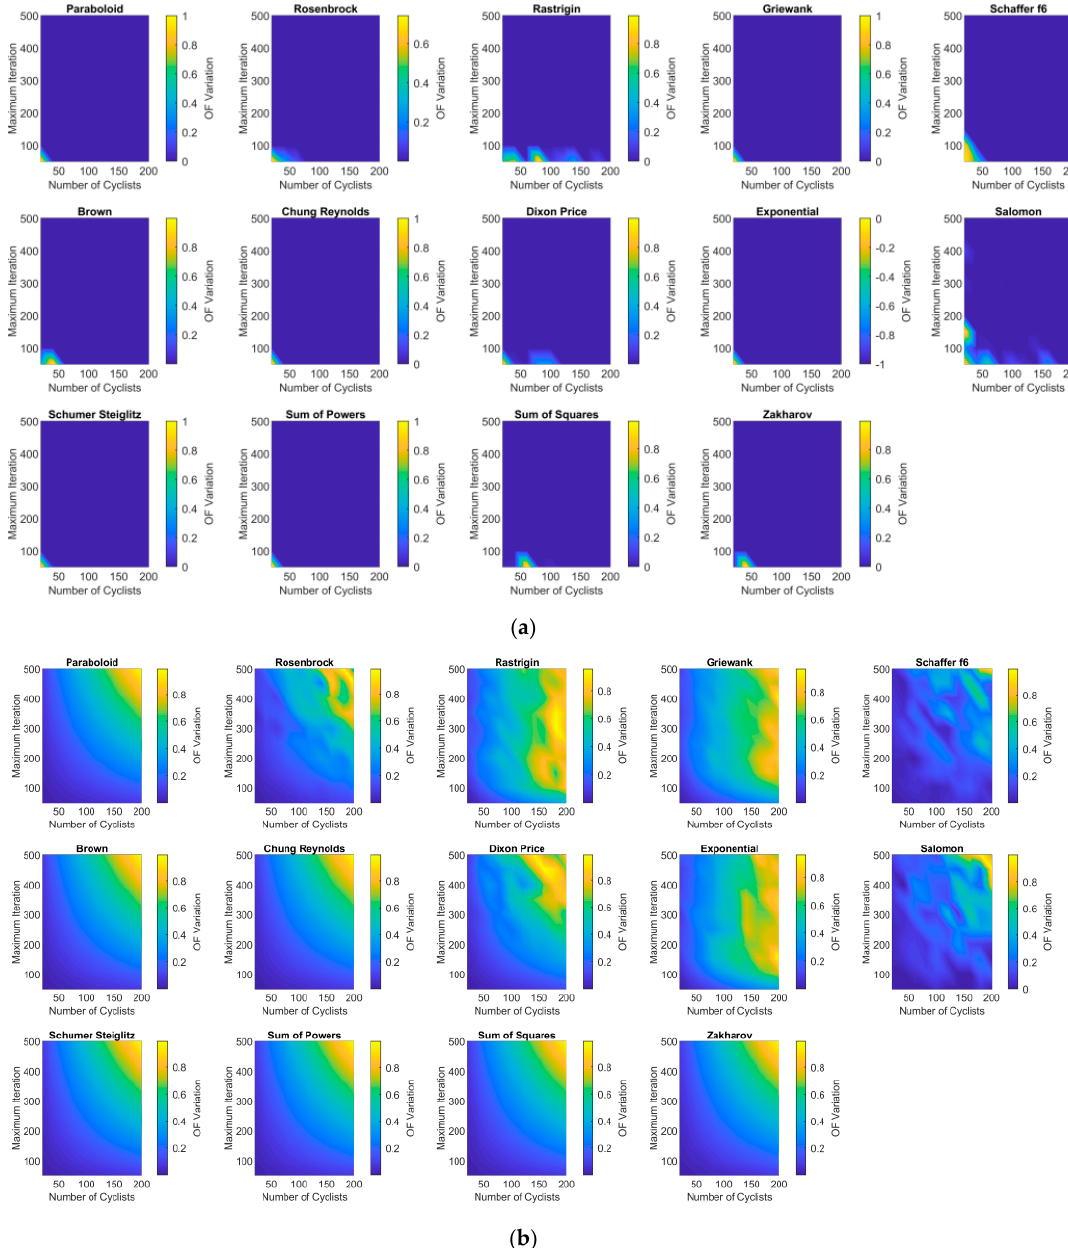
Figure 5. Sensitivity analysis for the number of cyclists and the maximum number of iterations: ( a ) Objective function variation; ( b ) Number of objective function evaluations.